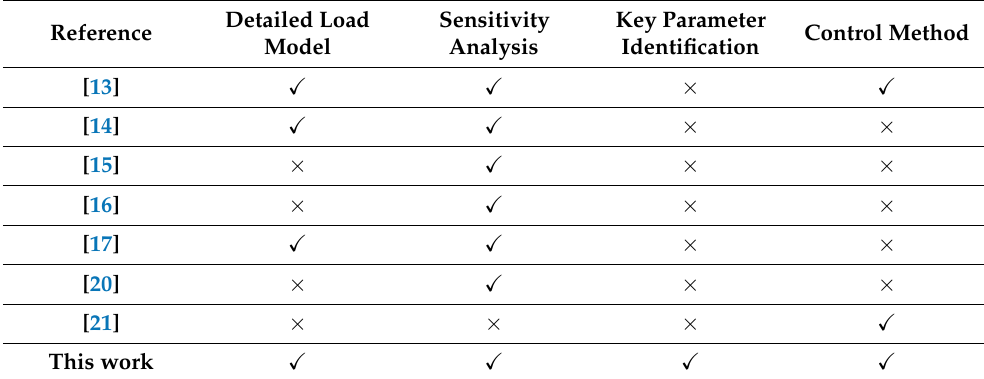
Table 1. Summary of the critical